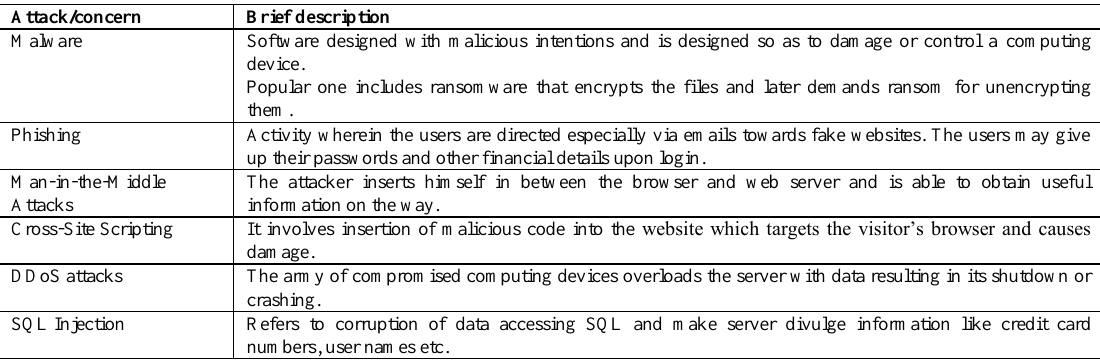
Table 1. Prominent types of cyber attacks (Kardon,